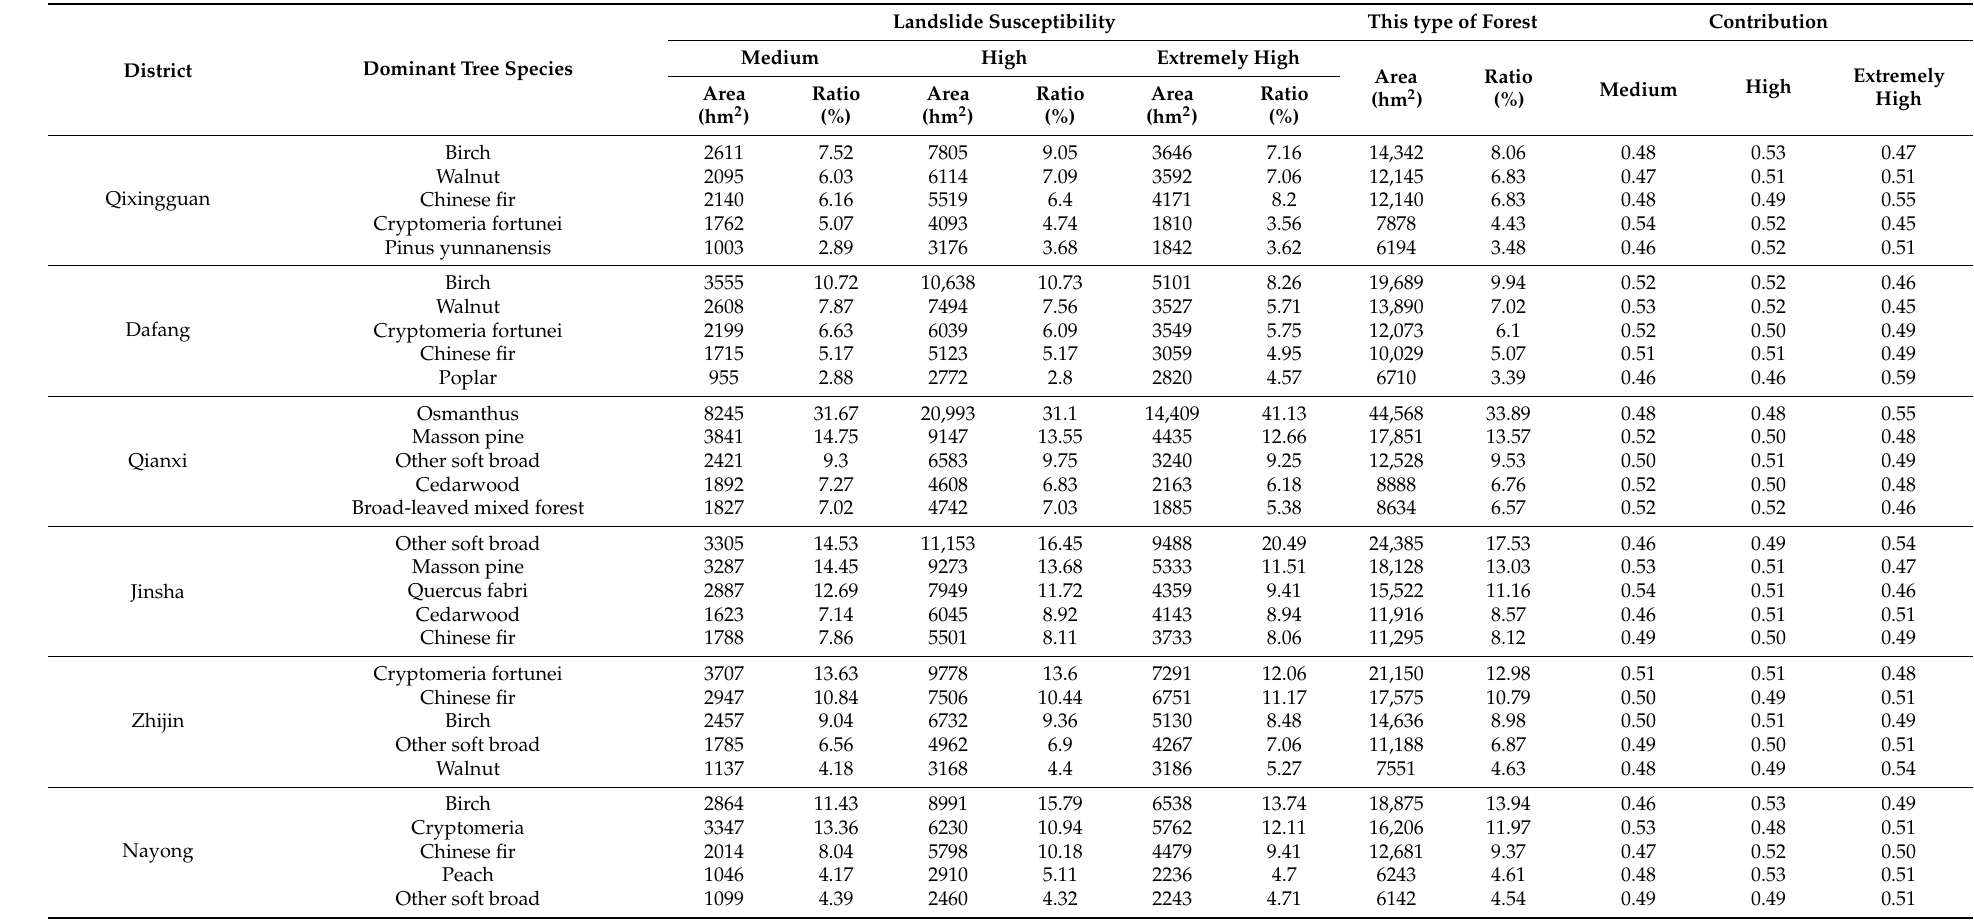
Table 4. Relationship between dominant tree species and landslide susceptibility in various districts and counties in Bijie